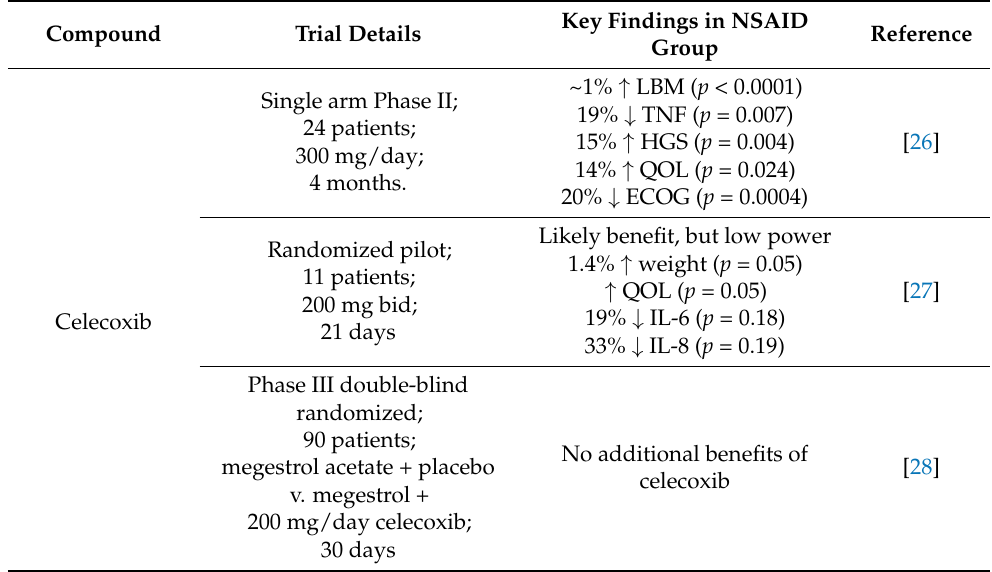
Table 1. NSAIDs in anti-cachexia clinical